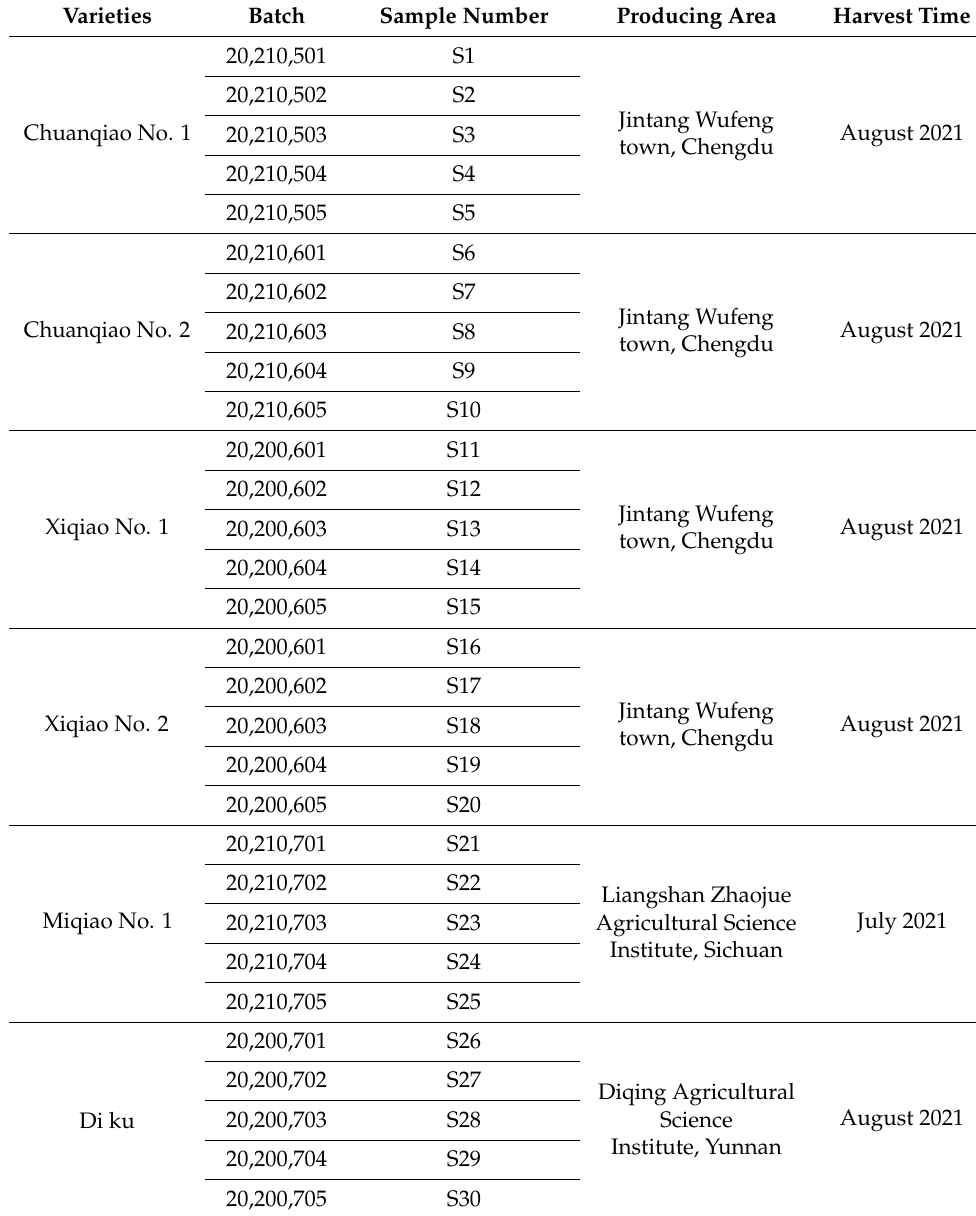
Table 4. Source information on different varieties of buckwheat. Varieties Batch Sample Number Producing Area Harvest